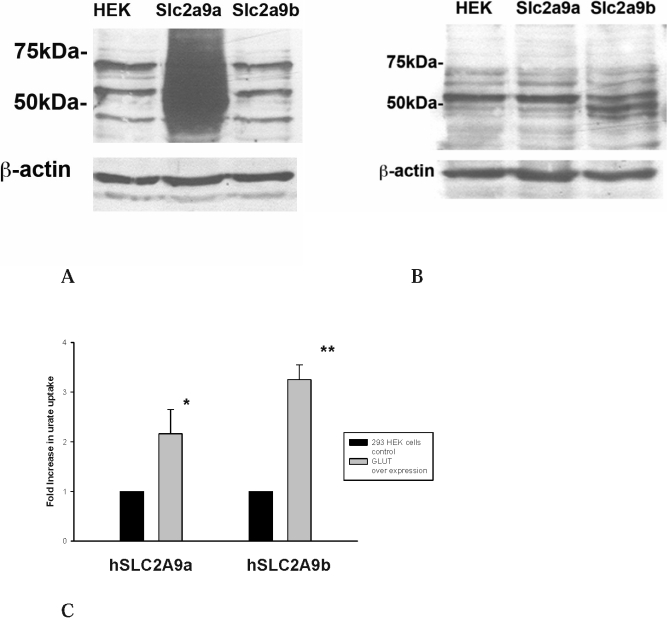
Specificity of Human SLC2A9a and SLC2A9b Antibodies and Urate Uptake into SLC2A9 Transfected Human Embryonic Kidney Cells(A) Western blotting of hSLC2A9 expressed in HEK cells. Expression of hSLC2A9a was detected as a broad band at approximately 50 kDa by a polyclonal antibody raised against the N terminus of SLC2A9a in HEK293 cells overexpressing SLC2A9a (middle lane, Slc2a9a) but not detected in cells overexpressing SLC2A9b (right lane, Slc2a9b), or nontransfected HEK cells (left lane, HEK).(B) Expression of hSLC2A9b in transfected HEK293 cells. hSLC2A9b was detected by a polyclonal antibody raised against the N terminus of hSLC2A9b in HEK293 cells overexpressing hSLC2A9b (right lane, Slc2a9b), but not detected in cells overexpressing hSLC2A9a (middle lane, Slc2a9a).(C) Increase in urate uptake in HEK293 cells overexpressing either hSLC2A9a or hSLC2A9b. Radiolabelled urate uptake was measured in human embryonic kidney cells, which were stably overexpressing SLC2A9a or SLC2A9b as compared to their respective nontransfected controls. Uptakes of 120 μM urate were measured over 6 min at 37 °C. *p < 0.05; **p < 0.02.